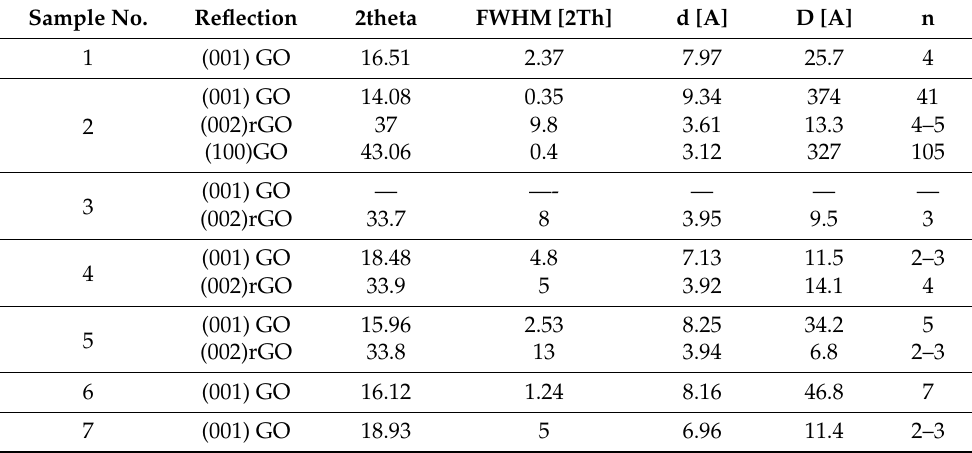
Table 3. Structural parameters of reduced graphene oxides resulting from XRD patterns. Sample No.